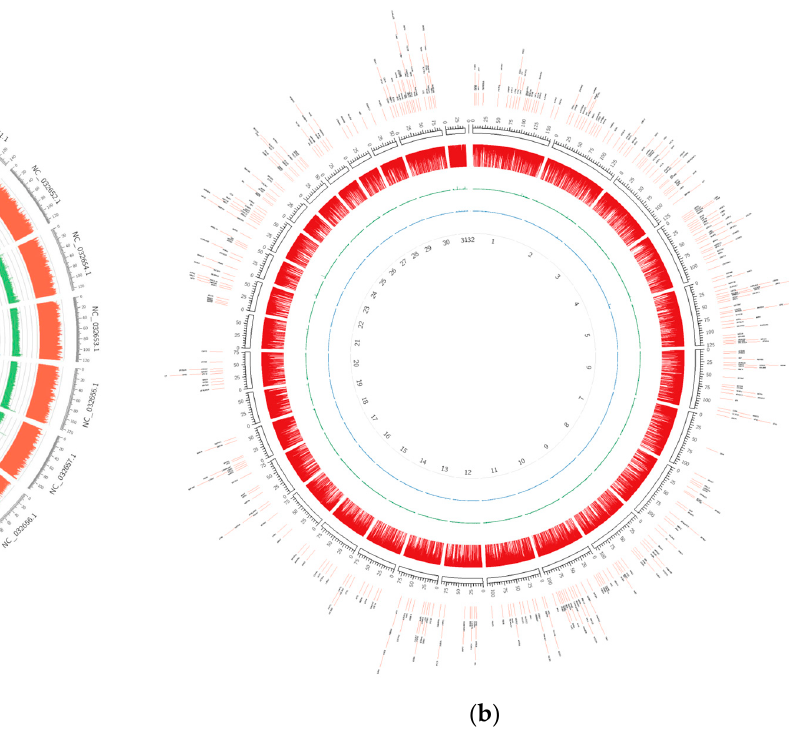
Figure 1. Whole-genome DNA methylation patterns of Yunnan zebu spleens and livers from No. 33. The red circle represents the CG methylation level, the green circle represents the CHG methylation level, and the blue circle represents the CHH methylation level. ( a ) PBI33. The outermost circle in the figure represents the chromosome scale, and the innermost circle represents the gene density. ( b ) GBI33. The outermost DMR in the figure are the chromosome scales, and the innermost numbers represent the chromosome numbers.